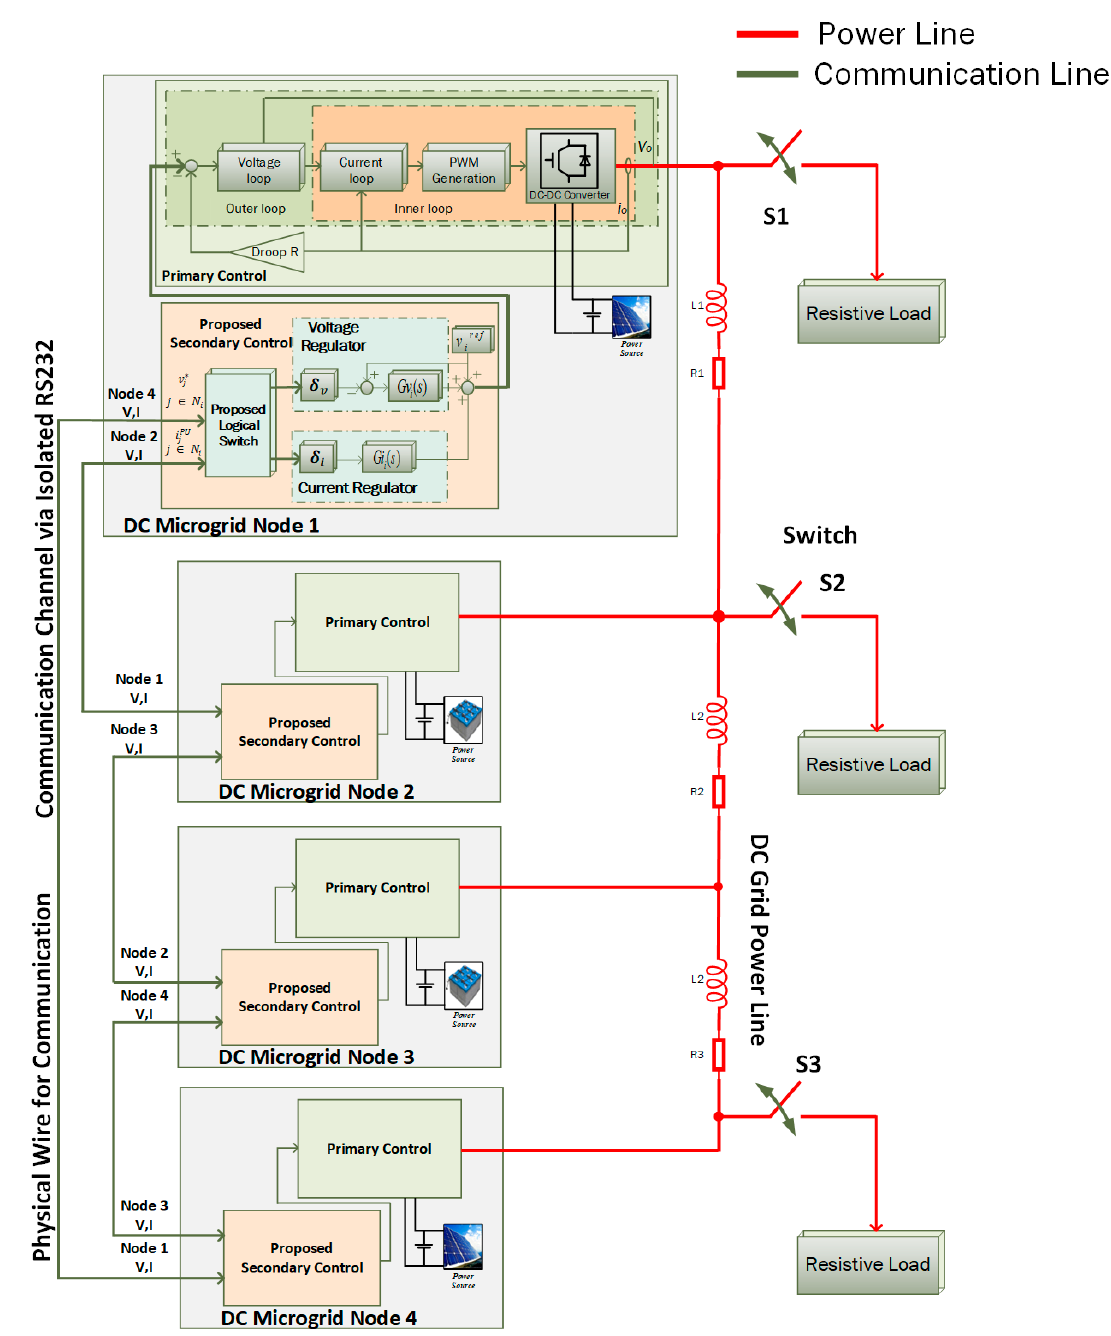
Figure 6. Proposed DC Microgrid experimental setup for case study.